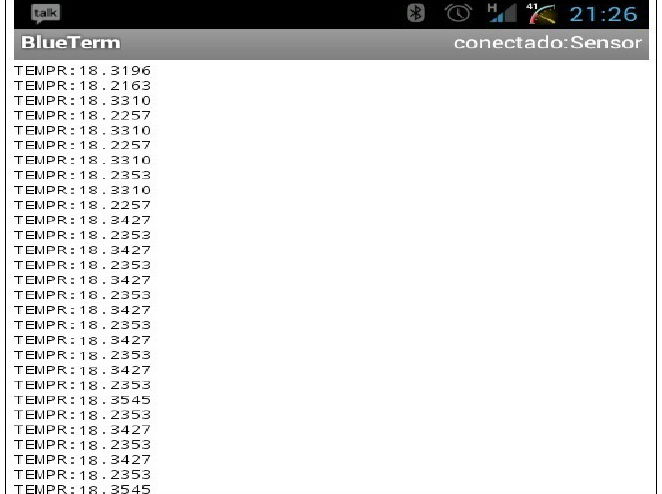
Figure 12. Receiving data via a terminal using the Android